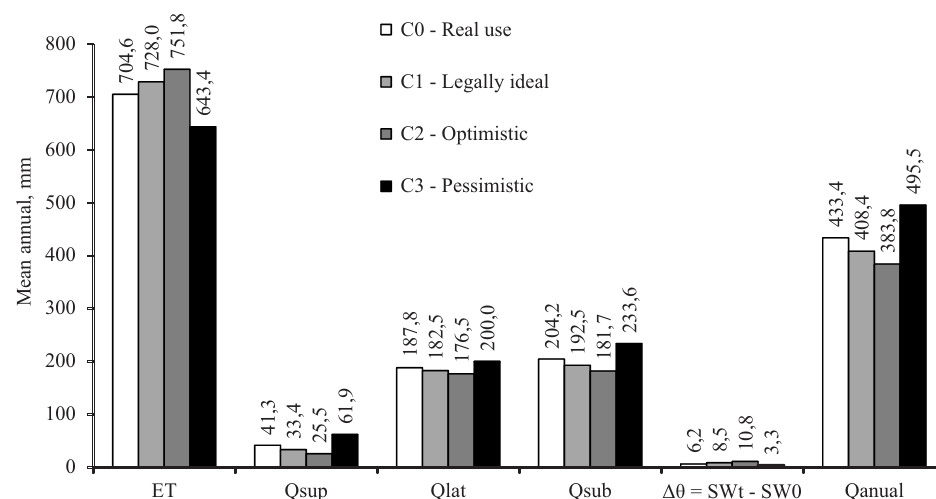
Figure 4. Evapotranspiration (ET), surface runoff (Q sur ), lateral flow (Q lat ), groundwater flow (Q sub ). variation of soil water storage ( ∆θ∆θ∆θ∆θ∆θ = SW t - SW 0 ) and mean annual runoff (Q annual ), all in mm, simulated from 1997 to 2003, for different land use scenarios proposed in the Galo creek watershed.